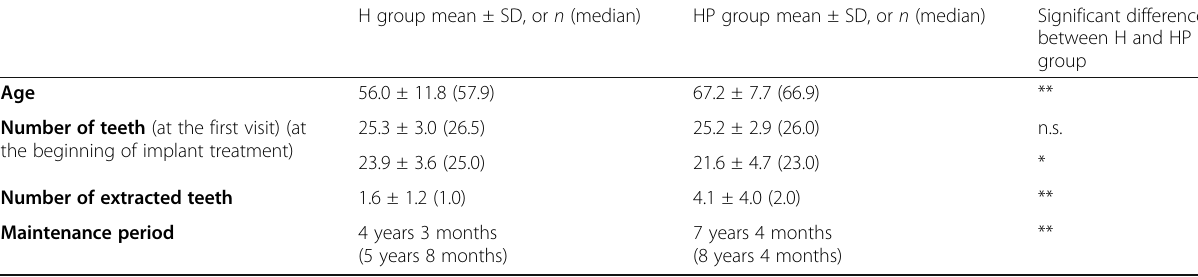
Table 2 Characteristics of the study population H group mean ± SD, or n (median) HP group mean ± SD, or n (median) Significant difference